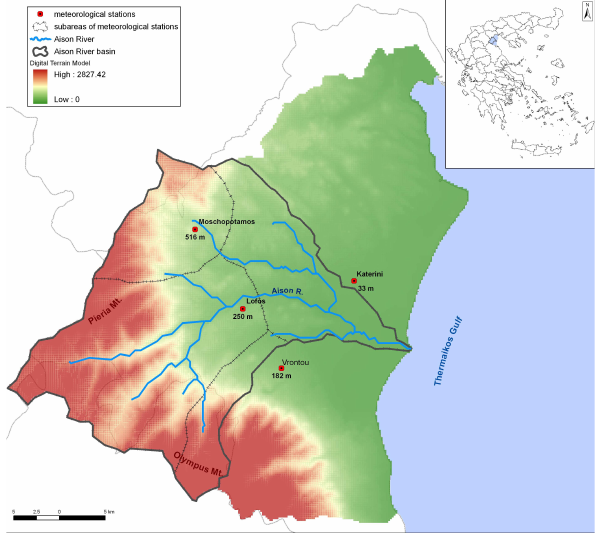
Figure 1. Aison River basin – Pieria (Greece) 3 4 Fig. 1. Aison River Basin – Pieria (Greece).